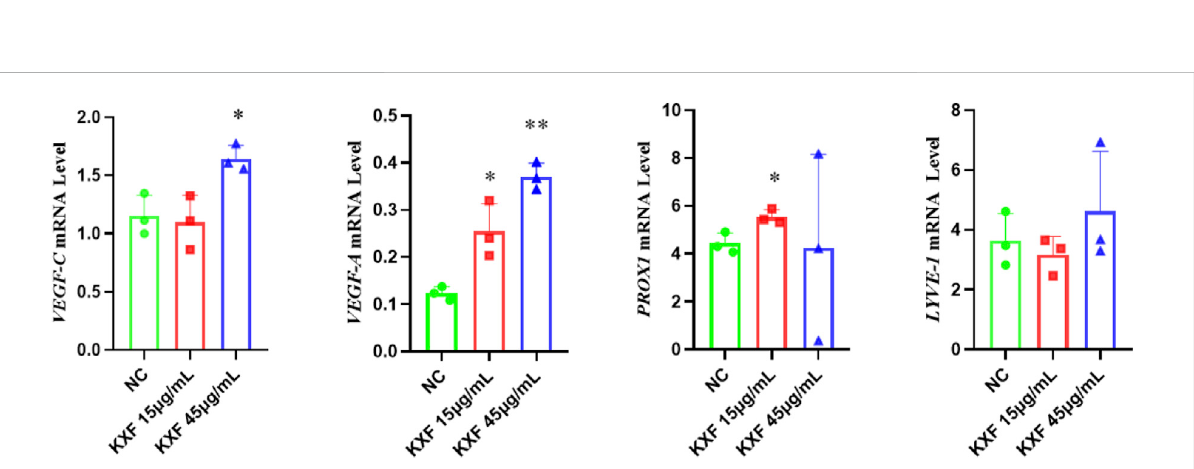
FIGURE 8 KXFpromotedtheexpressionofmRNAsrelatedtothelymphaticvessel.Theimagerepresentstheexpressionlevelsof VEGF-C , VEGF-A , PROX1 , and LYVE-1 mRNA in normal zebra fi sh with the treatment of two dosages of KXF for 48 h. * p < 0.05 vs. NC group, ** p < 0.01 vs. NC